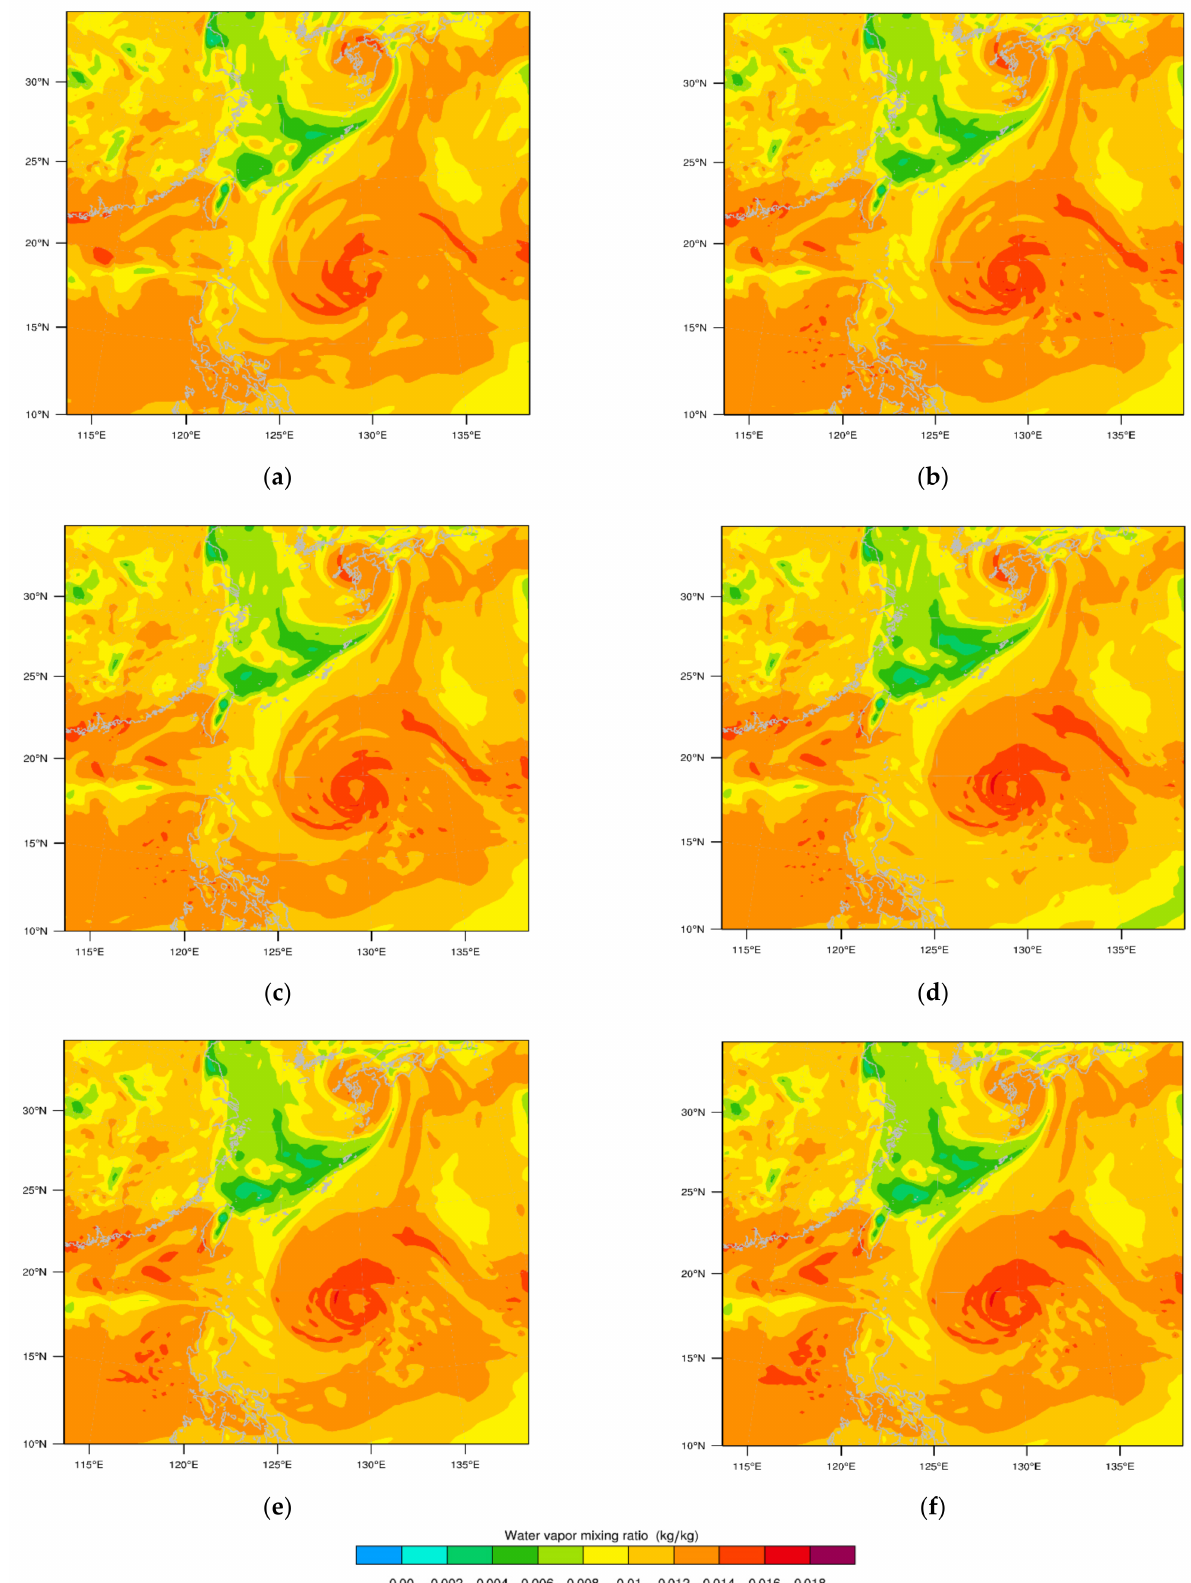
Figure 17. Water vapor mixing ratio (kg/kg) of the analyses at 0000 UTC 6 August 2019 at 850 hPa. ( a ) ERA-5, ( b ) CDA-3, ( c ) CDA-2, ( d ) CDA-1, ( e ) SDA, and ( f )